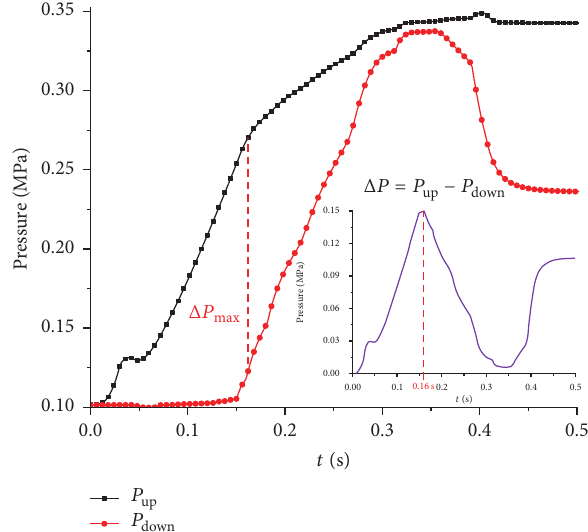
Figure 8: The variations of pressure values above and below the nozzle over time.